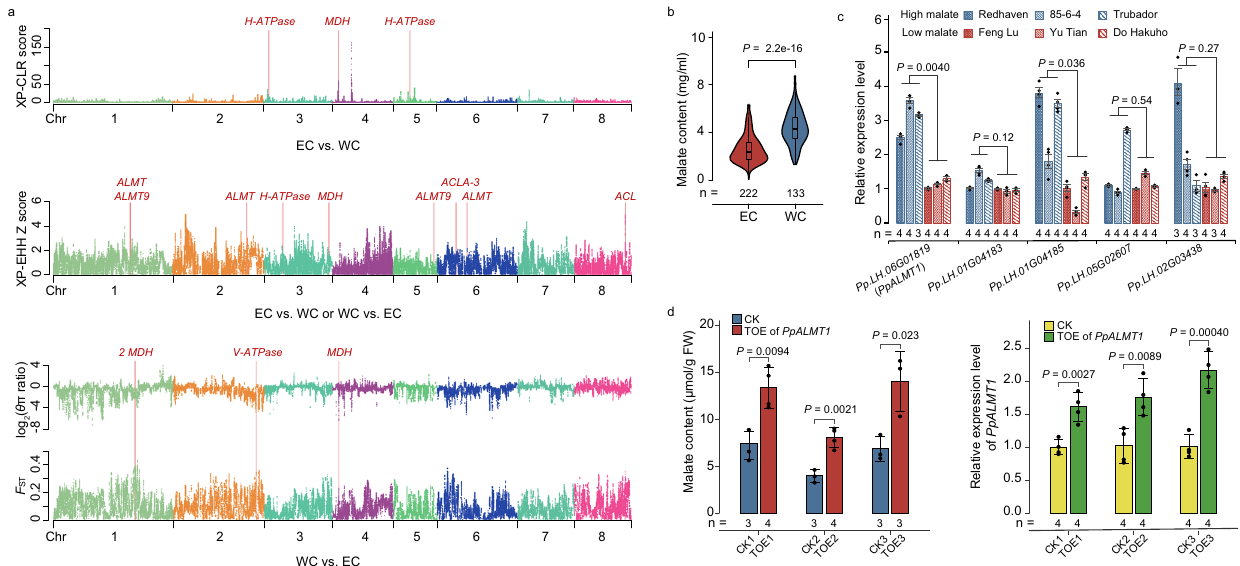
Fig. 3 Divergent selection for fruit acidity during modern peach breeding. a Selection signatures in the comparisons between ECs and WCs. Possible genes hypothetically under selection within the putative selective regions are labeled in red. b Signi fi cant divergence of the malate content between ECs ( n = 222) and WCs ( n = 133). In the violin plots (signi fi cance was tested with Wilcoxon tests), central line: median values; bounds of box: 25th and 75th percentiles; whiskers: 1.5 * IQR (IQR: the interquartile range between the 25th and 75th percentile). c Relative expression levels of the fi ve putative ALMT genes in fruits of three low-malate EC accessions vs. three high-malate WC accessions at 48 DAA (days after anthesis). The number ( n ) of individuals for each accession is shown below. Data were presented as the mean ± SE. Signi fi cance was tested with two-sided Student ’ s t -tests. d A signi fi cantly elevated level of malate content (left) in peach mesocarp tissues transiently over-expressing (TOE) PpALMT1 (right). Fruit mesocarps transiently transformed with the empty vector were used as controls (CK). The number ( n ) of each independent experiment is shown below. Data were presented as the mean ±